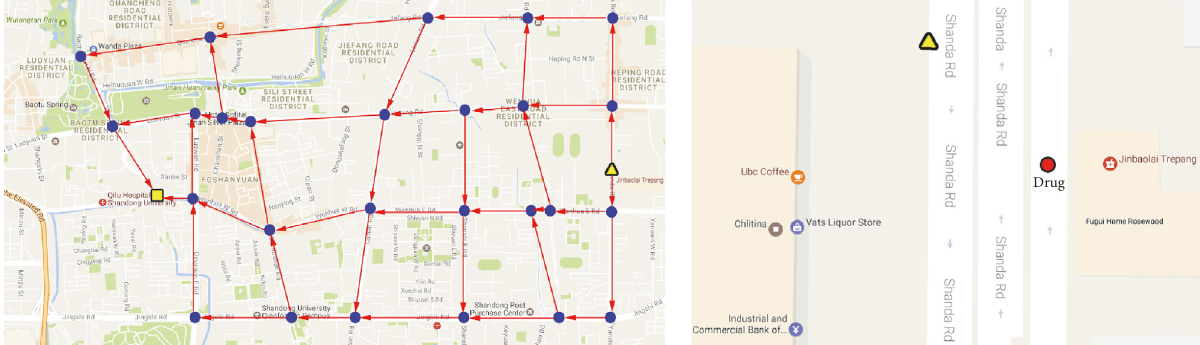
Figure 3: The evacuation